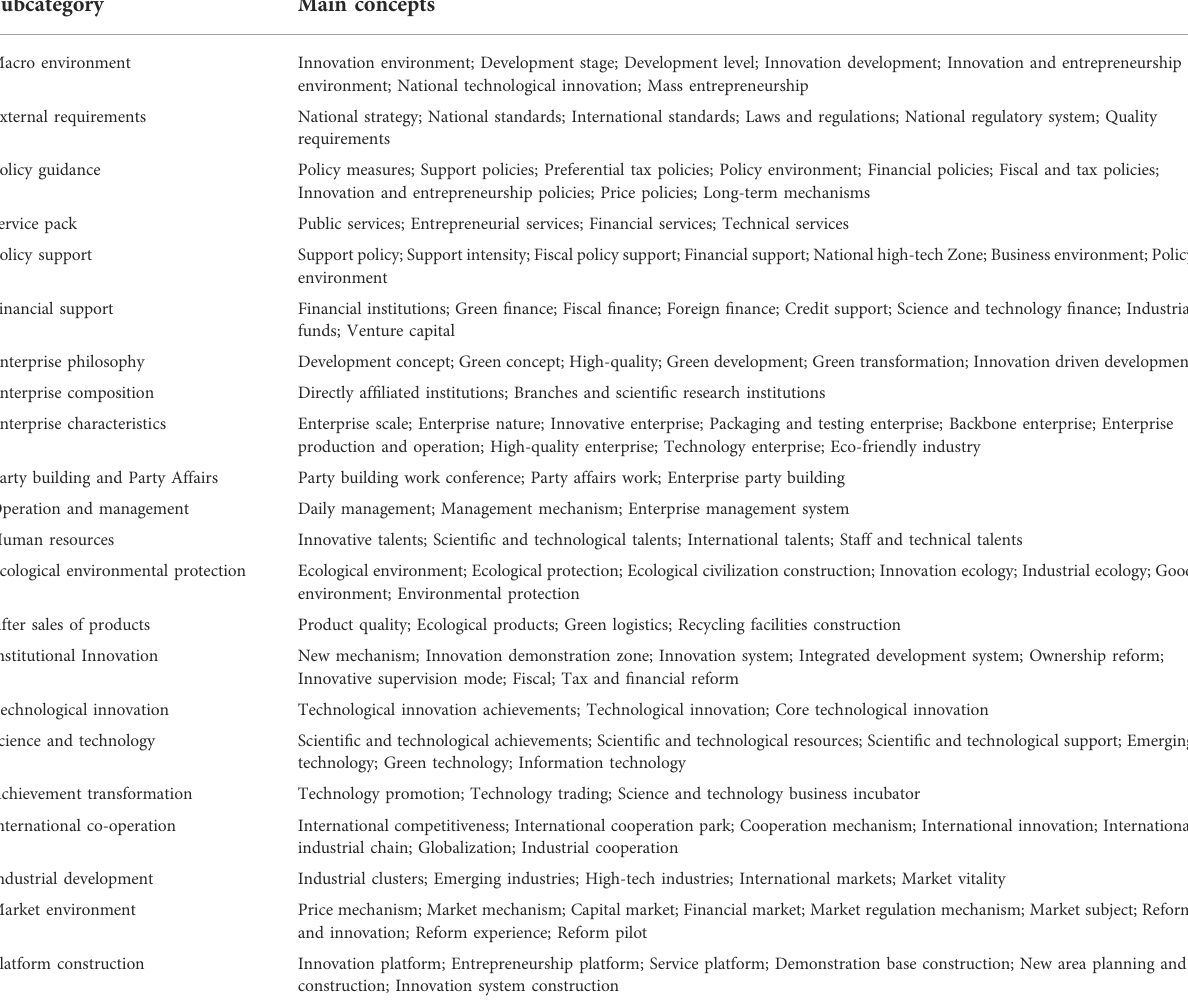
TABLE 4 Open-coding